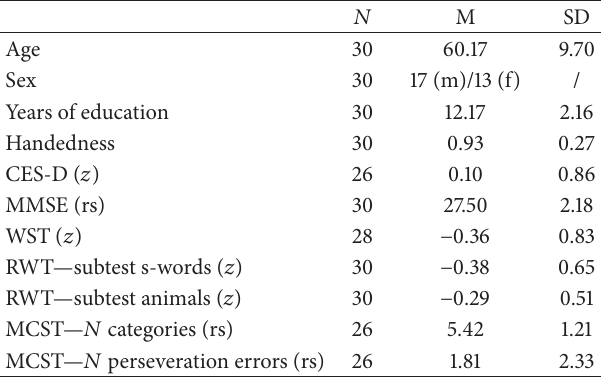
Table 1: Demographic and neuropsychological patient characteris-